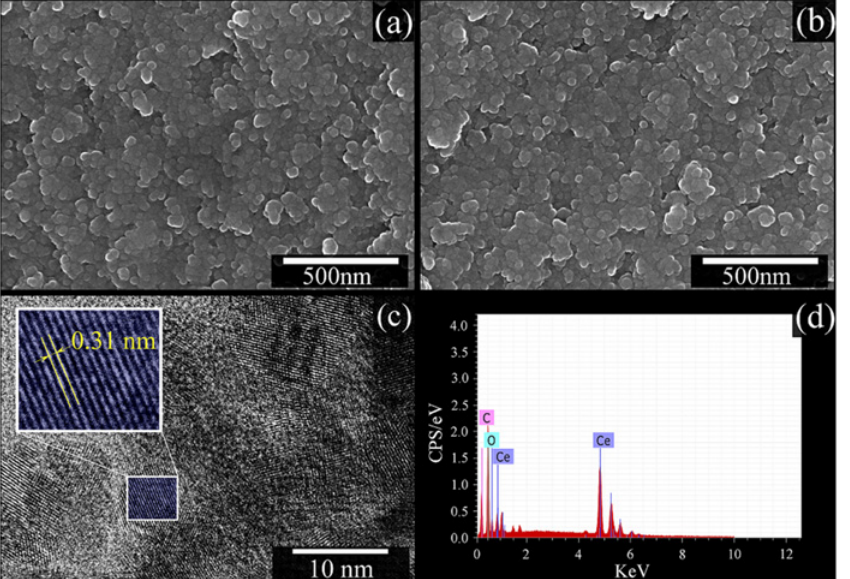
Fig 2. (a) and (b) SEM images, (c) HRTEM image and (d) EDS analysis of the CeO2